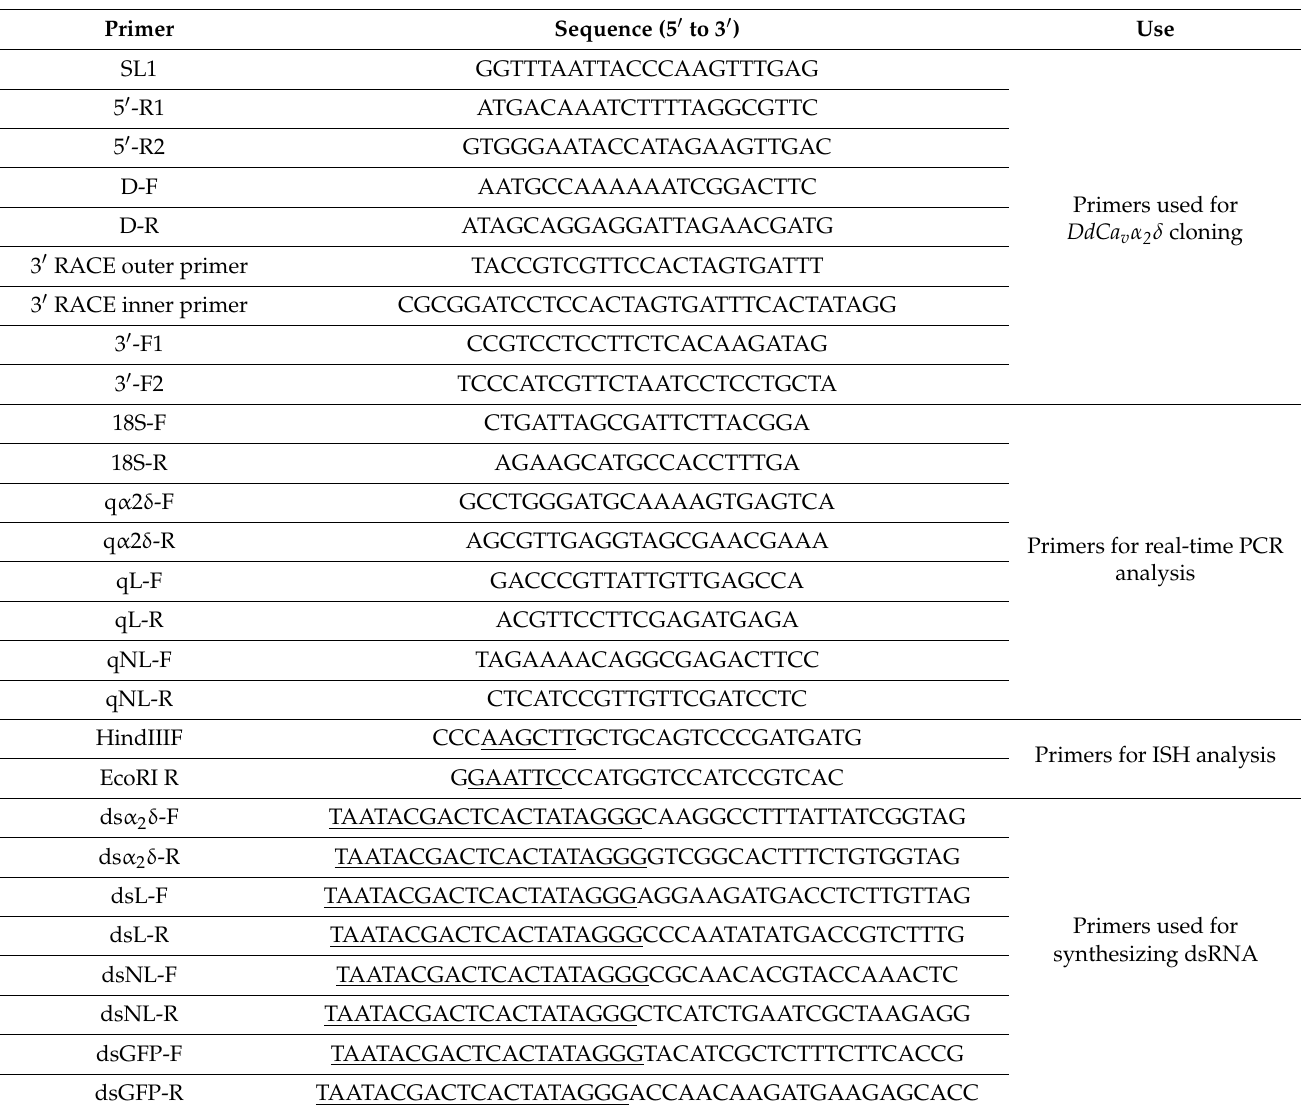
Table 1. Primers used in the